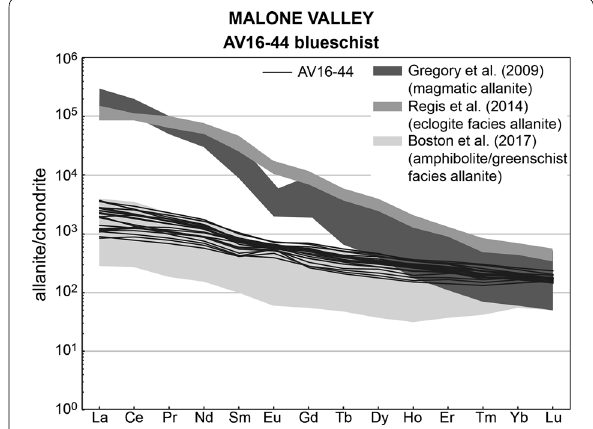
Fig. 5 Allanite REE patterns in Blueschist AV16-44 from Malone Valley (black lines). REE patterns are compared to those of magmatic allanites from the Bergell Pluton (Gregory et al. 2009), of HP allanites in a metapelite from the Mombarone area of the EMC (Regis et al. 2014) and of amphibolite to greenschist facies allanite rims in a calcschist from Campolungo in the Central Alps (Boston et al.